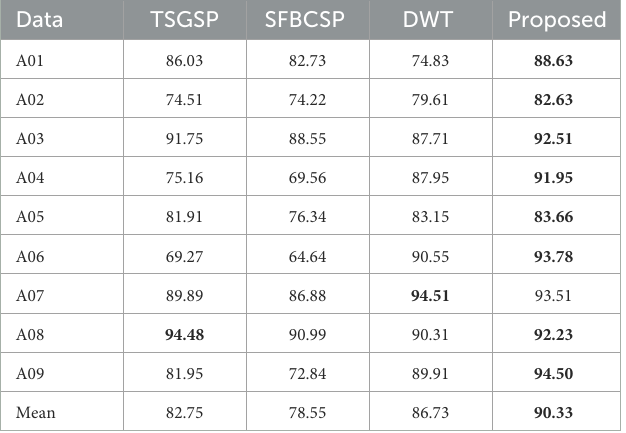
TABLE 8 The classification accuracy for feature selection and comparison algorithms on dataset IV2a.